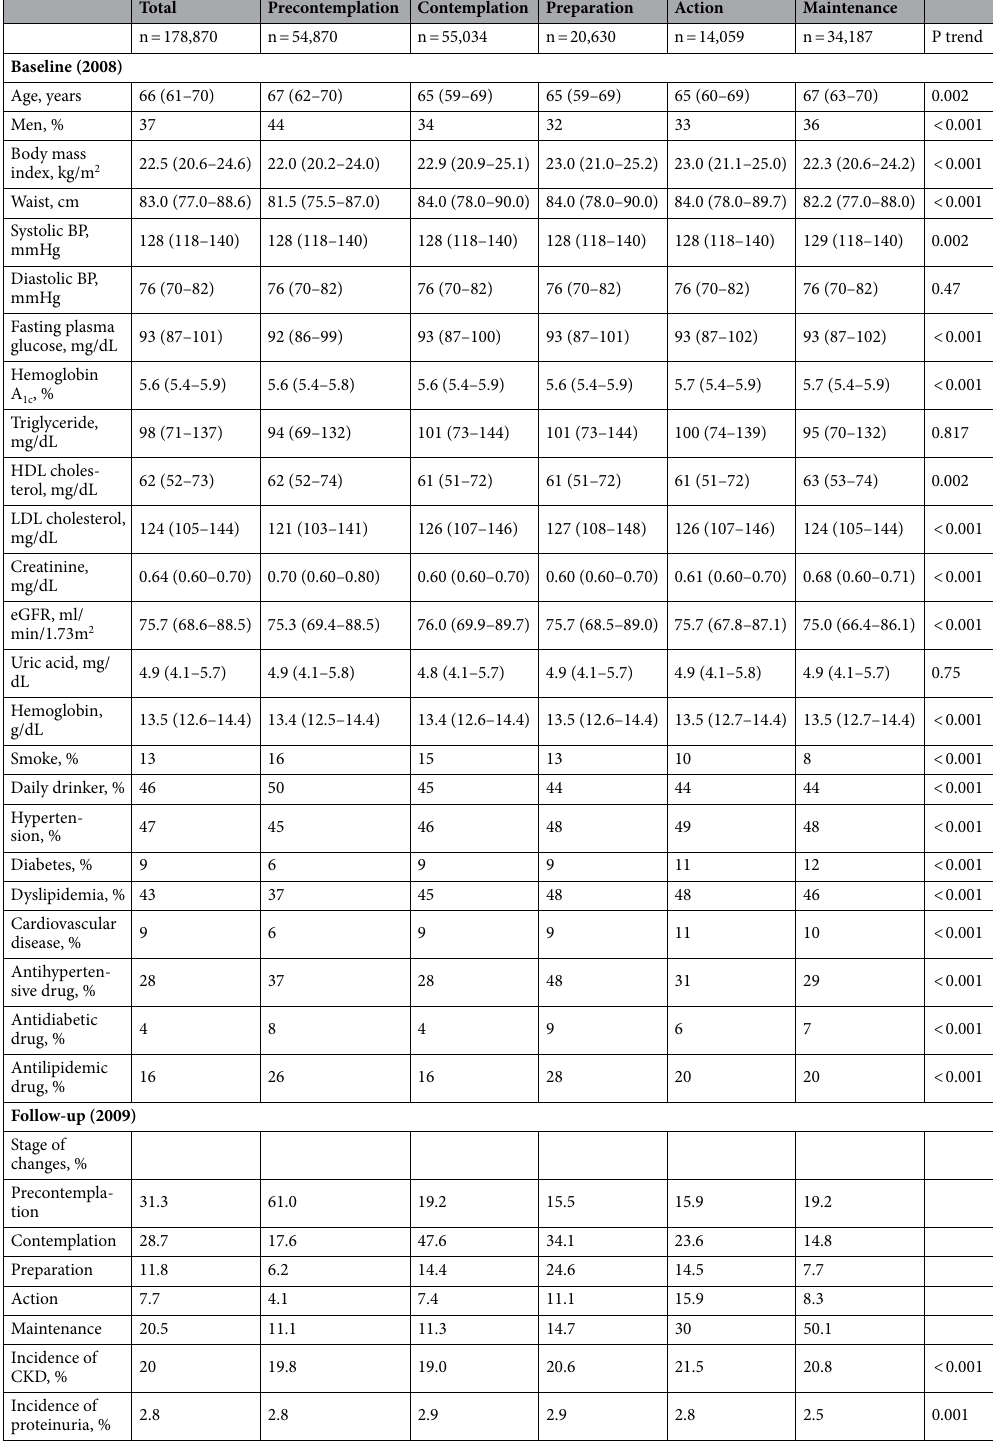
Table 1. Clinical characteristics of 178,780 participants according to the stage of healthy lifestyle change. Values are expressed as medians (interquartile range), or percentage as appropriate. BP blood pressure,